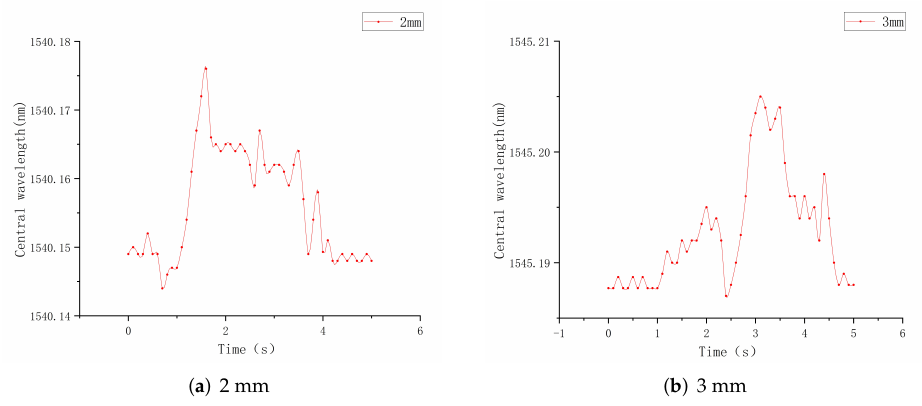
Figure 23. Calibrated wavelength relationship diagram.